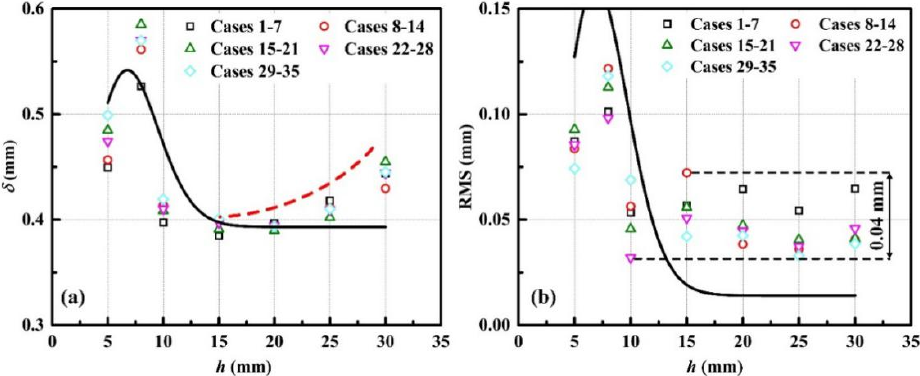
Figure 11. Variations of the liquid film thickness at r = 5 mm. ( a ) variations of the time-average film thickness, ( b ) variations of the RMS in Cases 1–35.